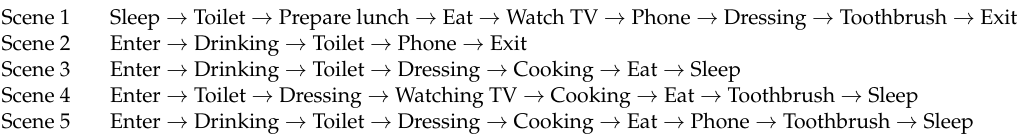
Table 1. Sequence activities of the case scenes.